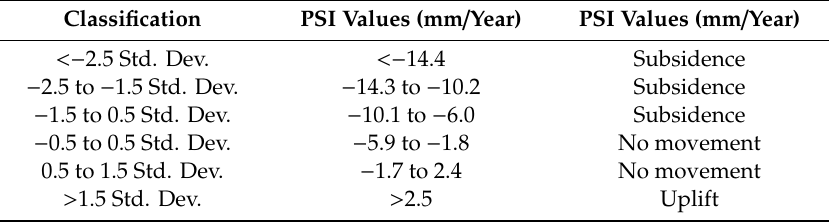
Table 3. Values used for thresholding the PSI data of time series